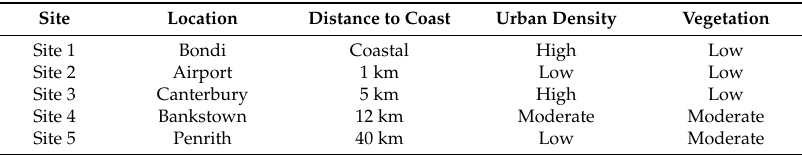
Table 2. Characteristics of the five